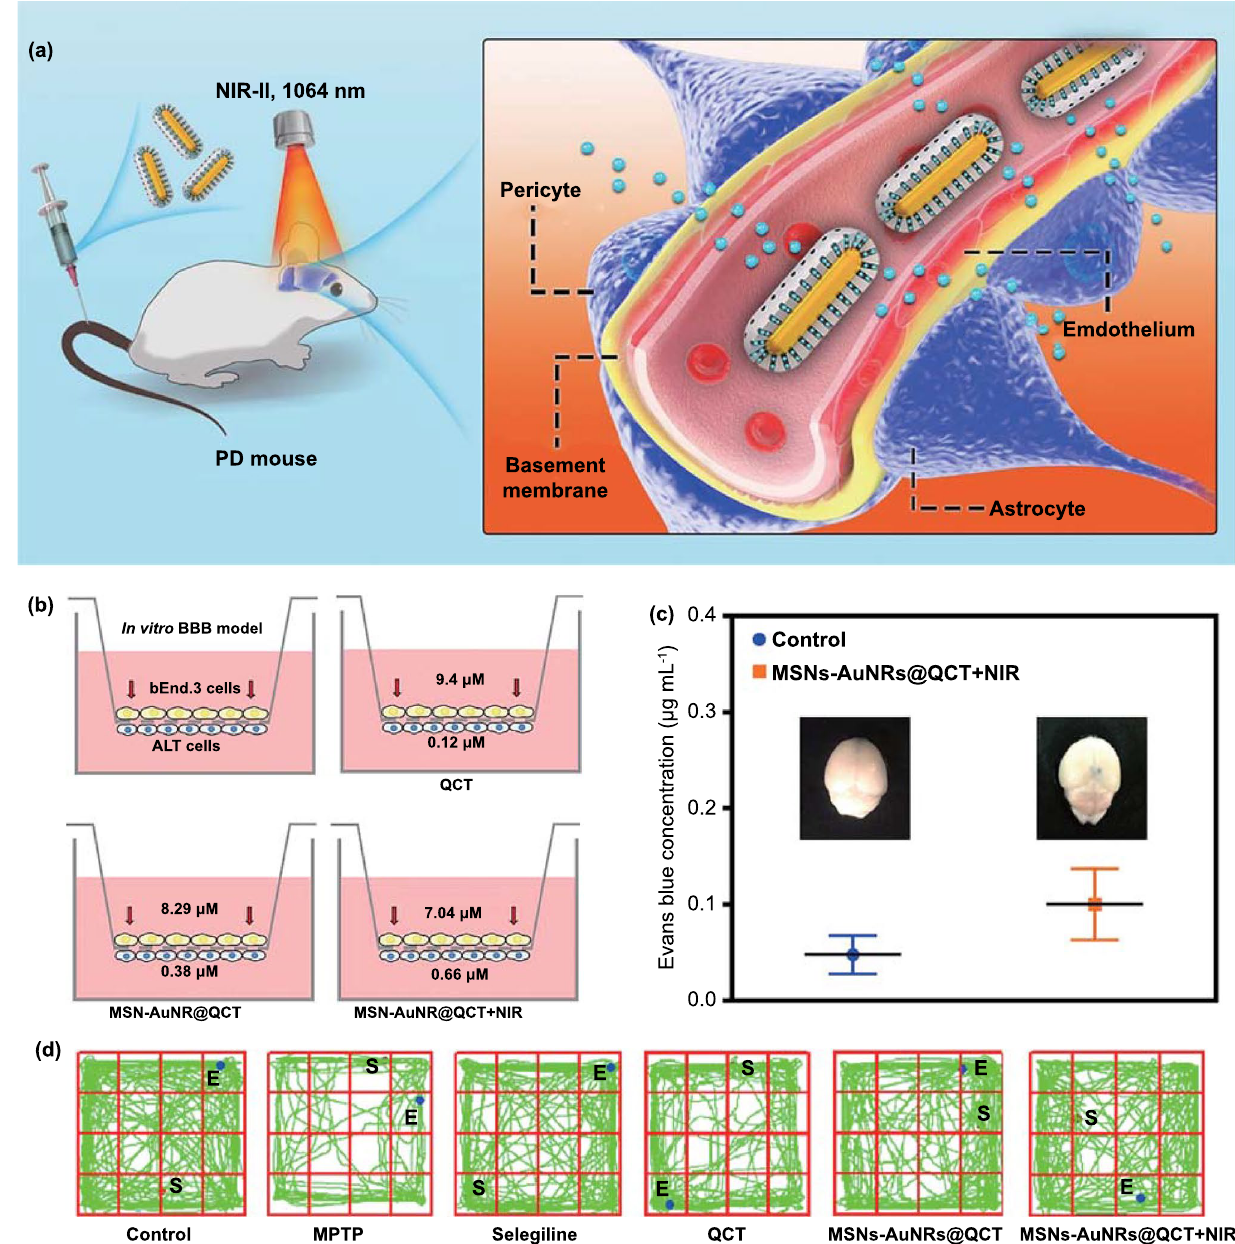
Fig. 8 Example of photothermal brain delivery. a The proposed mechanism underlying MSNs-AuNRs@QCT penetration across the BBB under NIR-II (1064 nm) laser irradiation. b Overview of the in vitro BBB Transwell system used to gauge the penetrative capabilities of MSNs- AuNRs@QCT, and the final concentration of QCT in the apical and basolateral chambers in the BBB transwell system. c Photothermal effect on BBB permeability after MSNs-AuNRs@QCT injection and 1064 nm laser irradiation, examined using Evans blue as a BBB permeability indicator. d Representative movement of mice in an open-field box (green). Adapted with permission from Ref. [121]. Copyright 2020 American Chemical